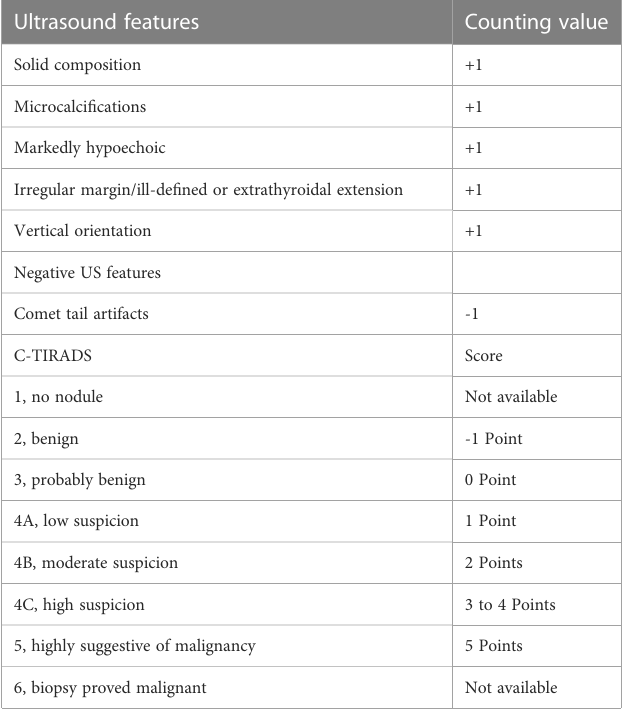
TABLE 2 Chinese thyroid imaging reporting and data system